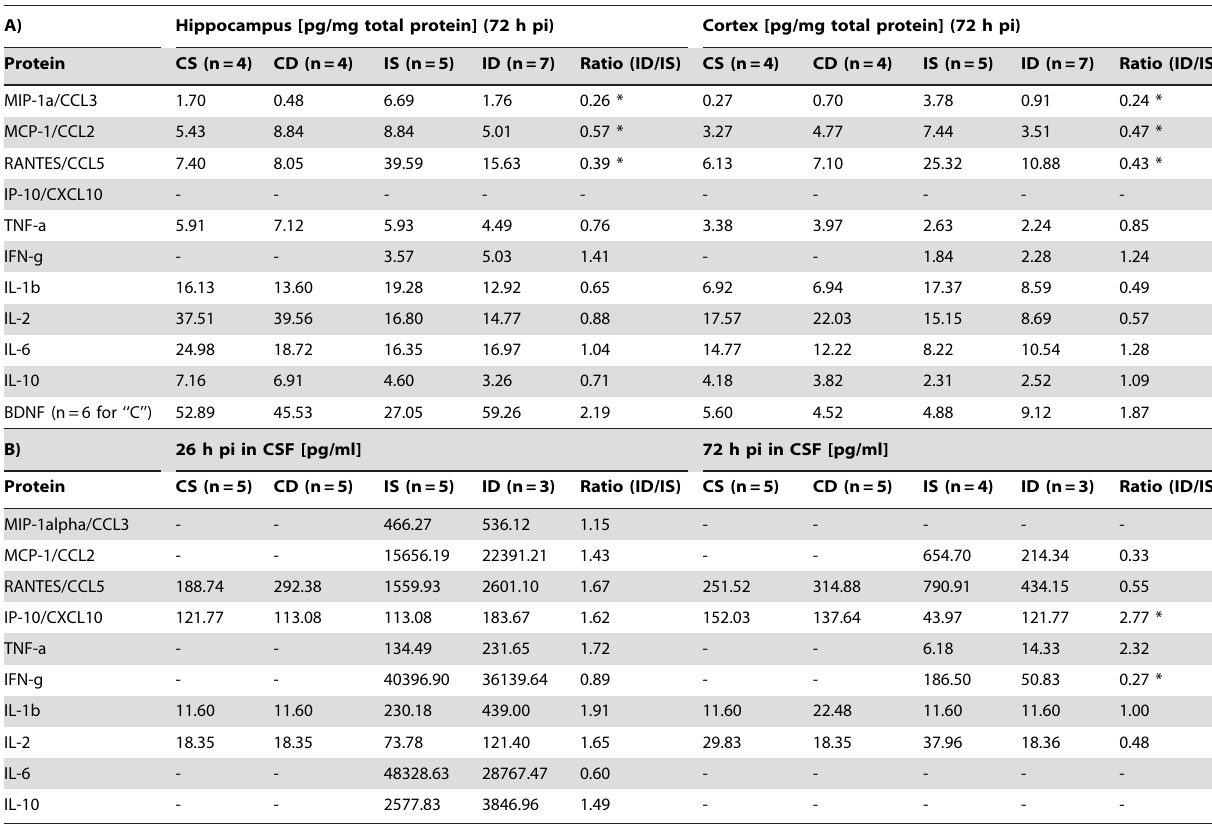
Table 3. Results of the multiplex immunoassays in tissue homogenates (A) and/or cerebrospinal fluid (B).